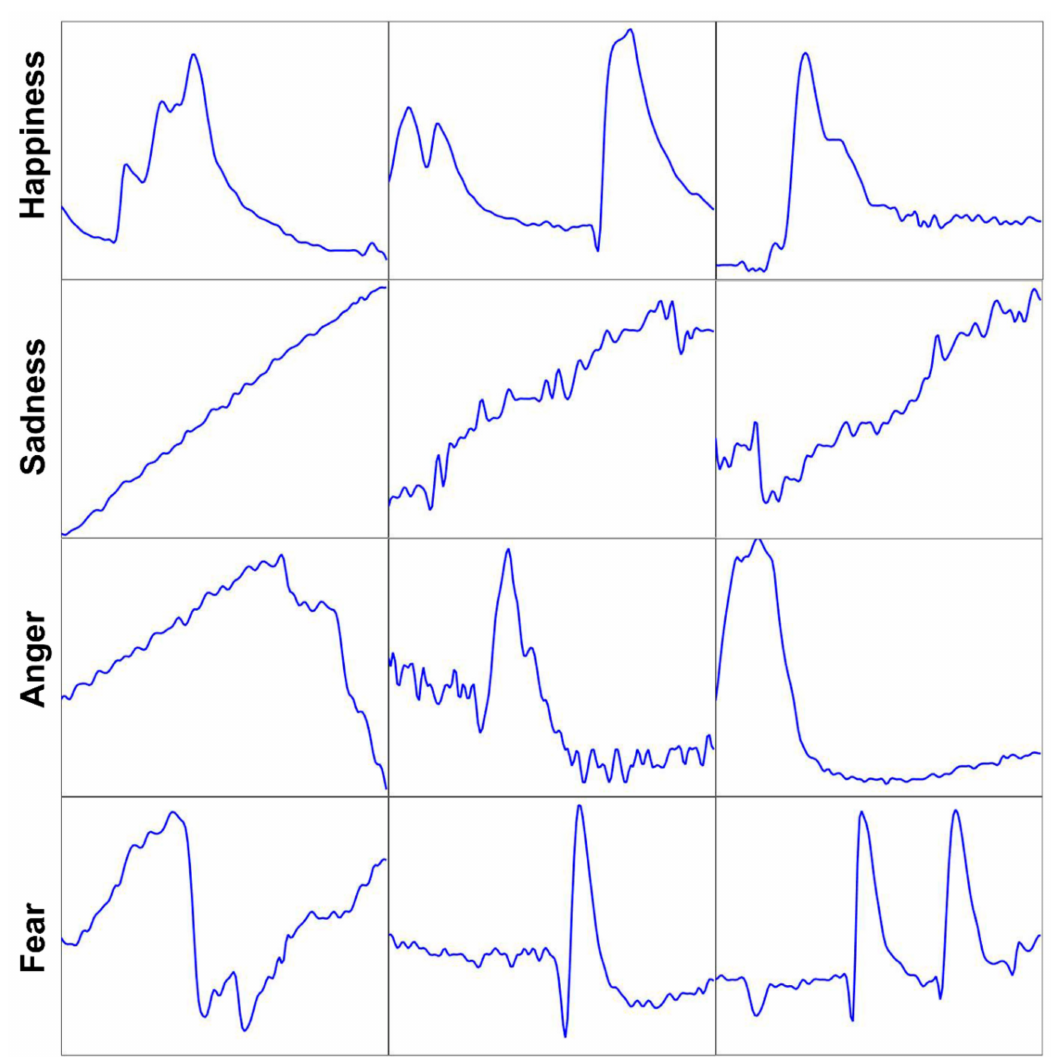
Figure 8. Twelve emotion samples of happiness, sadness, anger and fear.